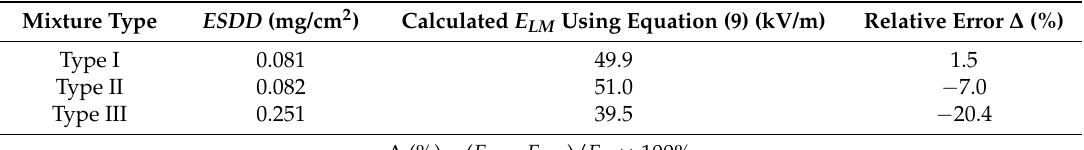
Table 9. Flashover voltage gradient correction considering each constituent’s contribution to ESDD .